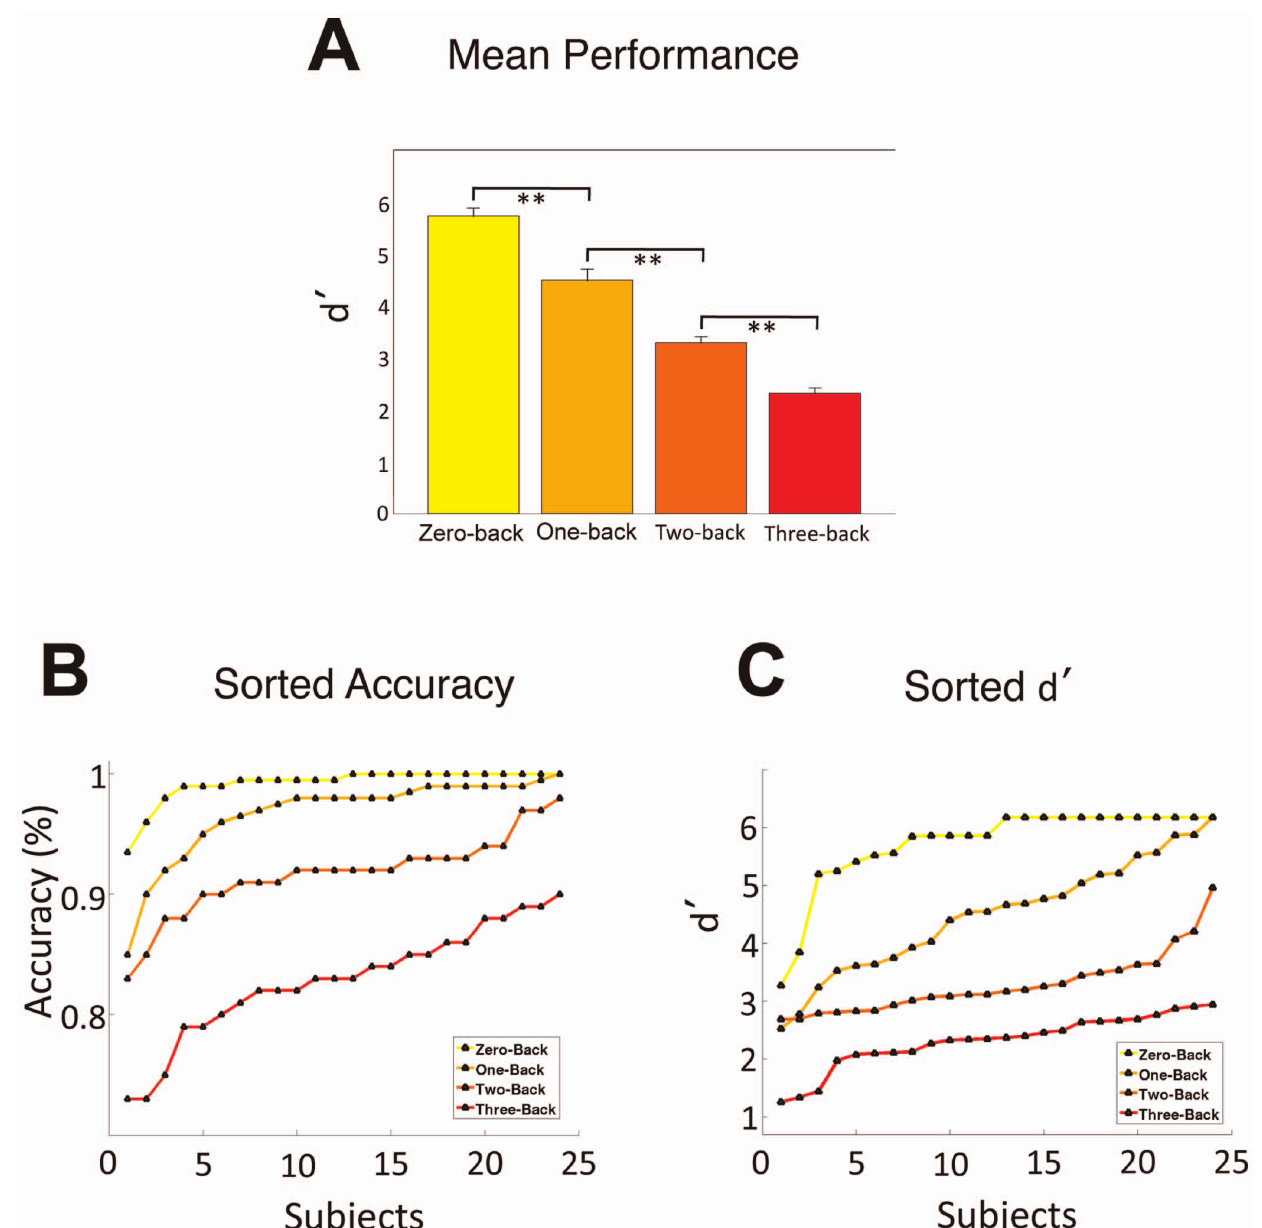
Figure 2. A: Mean Performance ( 6 standard error). Performance significantly decreased with increasing task difficulty. B: Individual subject accuracy for each n-back condition. The three-back condition has a more linear distribution than the other two conditions and no ceiling effect (linear regression fit: zero-back r 2 =0.46; one-back r 2 =0.66; two-back r 2 =0.85; three-back r 2 =0.93). C: Individual subject d 9 for each n-back condition. (linear regression fit: zero-back r 2 =0.58; one-back r 2 =0.98; two-back r 2 =0.81; three-back r 2 =0.89) **=p , 0.01, Bonferroni corrected. doi:10.1371/journal.pone.0066820.g002 fT 2 /cm 2 , p , 0.001; 2 1326 occipital fT 2 /cm 2 , p , 0.001). In the power across regions (anterior frontal, posterior frontal, temporal, parietal, occipital) and conditions (eyes open and eyes closed) for alpha band, there was a significant interaction of region and each frequency band. The Huynh-Feldt correction was used to condition effects (p , 0.001). Power was also significantly decreased adjust for heterogeneity of variance in multiple degrees-of-freedom in the eyes open relative to the eyes closed condition (temporal 2 417 fT 2 /cm 2 , p , 0.001; parietal 2 1201 fT 2 /cm 2 , p , 0.01; tests. Figure 3 displays graphs of the results. In the delta/theta band, there was a significant interaction of region and condition occipital 2 2405 fT 2 /cm 2 , p , 0.001). The beta band also exhibited effects (p , 0.001). Power significantly decreased in all regions in a significant interaction between condition and region (p , 0.001), the eyes open relative to the closed condition (anterior frontal: with regional decreases in the eyes open relative to closed 2 173 fT 2 /cm 2 , p , 0.05; posterior frontal: 2 786 fT 2 /cm 2 , condition (temporal 2 63 fT 2 /cm 2 , p , 0.001; parietal 2 271 fT 2 / p , 0.01; temporal: 2 364 fT 2 /cm 2 , p , 0.001; parietal: 2 1119 cm 2 , p , 0.001; occipital 2 492 fT 2 /cm 2 , p , 0.001).